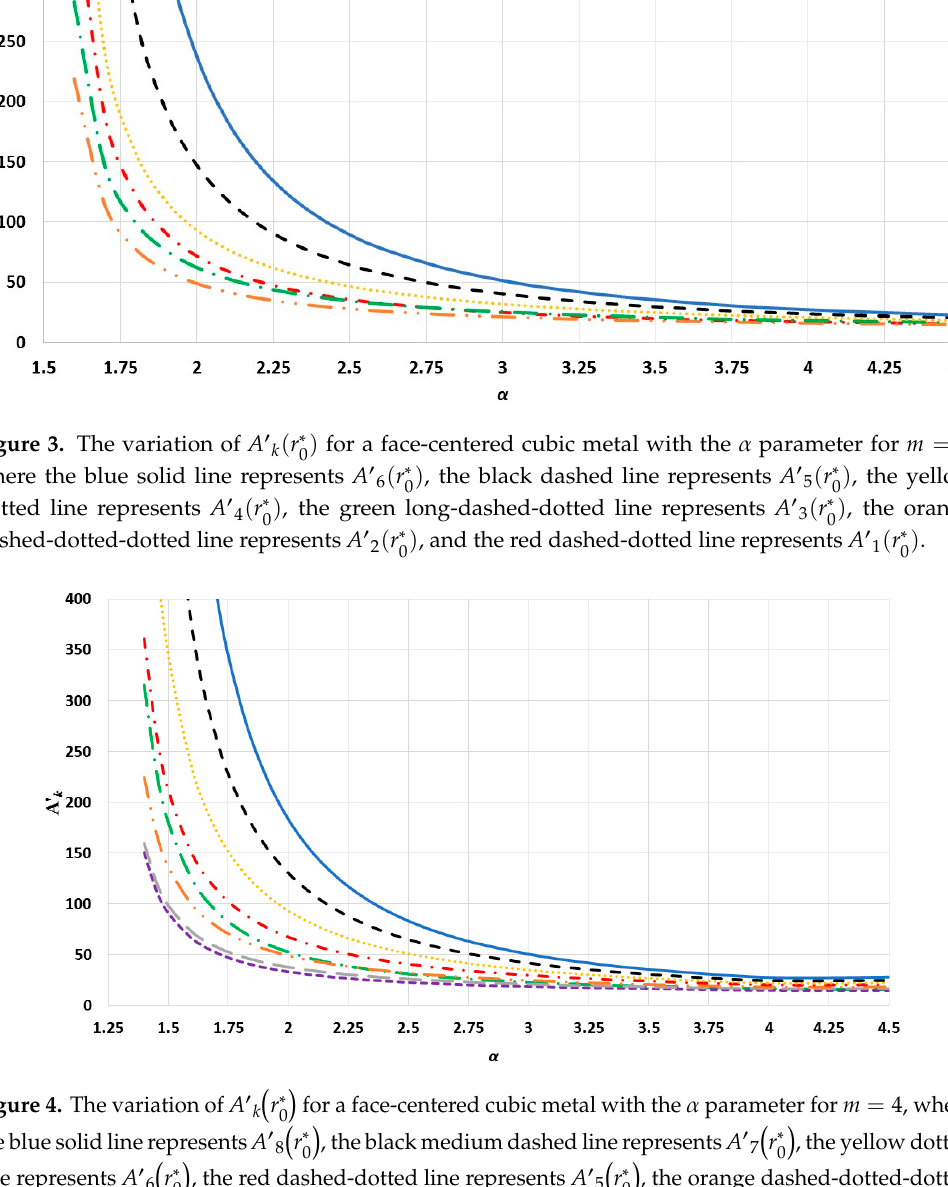
(cid:16) (cid:17) r ∗ , the yellow dotted 0 (cid:16) (cid:17) r ∗ , the orange dashed-dotted-dotted 0 (cid:16) (cid:17) r ∗ , the purple short-dashed line 0 (cid:16) (cid:17) r ∗ 0